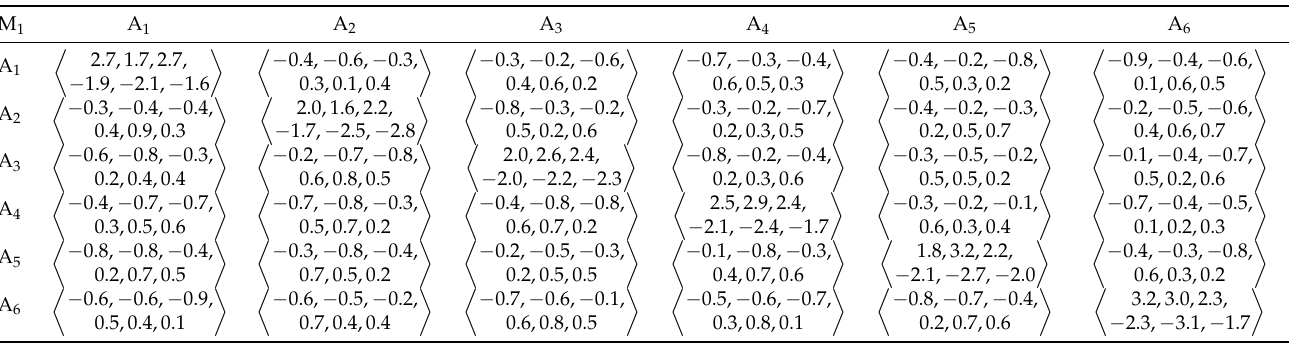
Table 12. Elements of the Laplacian matrix of the BSVNDG, D 1